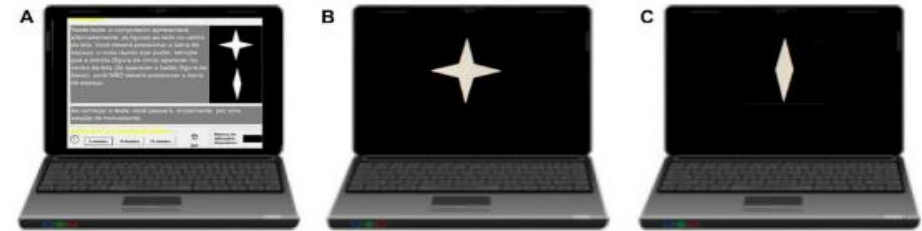
Figure 1. Schematic overview of the set-up of the attentional test (CVAT). ( A )–The CVAT starts with